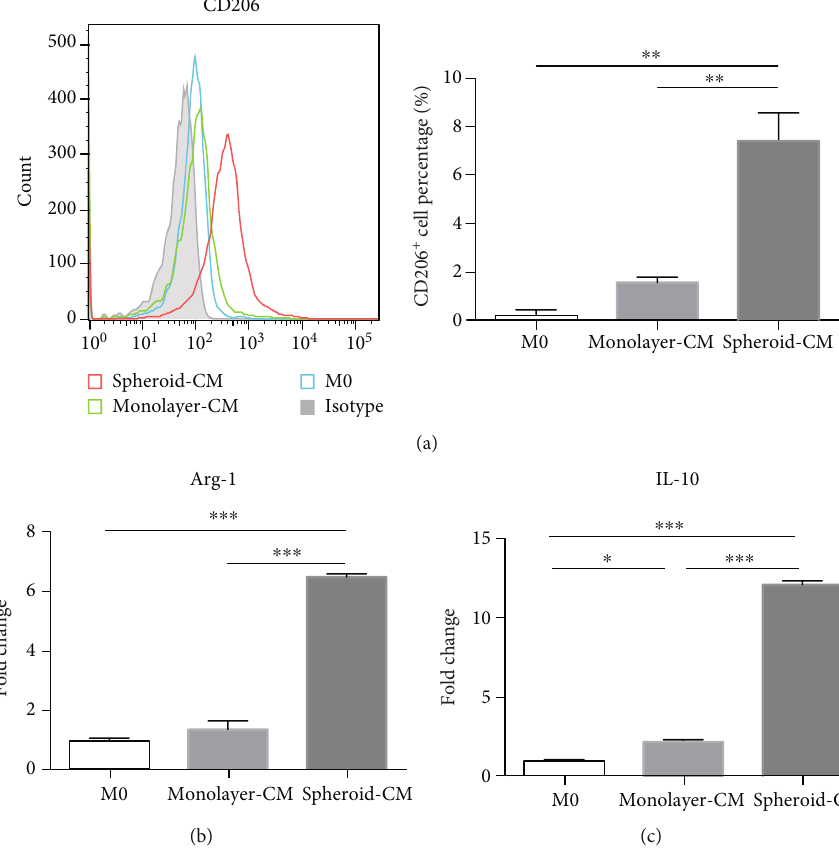
Figure 5: ADSC spheroids promote polarization of macrophages into M2 phenotype more e ff ectively in vitro . (a) The percentage of CD206- positive macrophages was determined by fl ow cytometry. Data are displayed as mean ± SEM . ∗∗ P < 0 : 01 . (b, c) qPCR measurements for M2 macrophage markers Arg-1 and IL-10. Data are displayed as mean ± SEM . ∗ P < 0 : 05 , ∗∗∗ P < 0 : 001